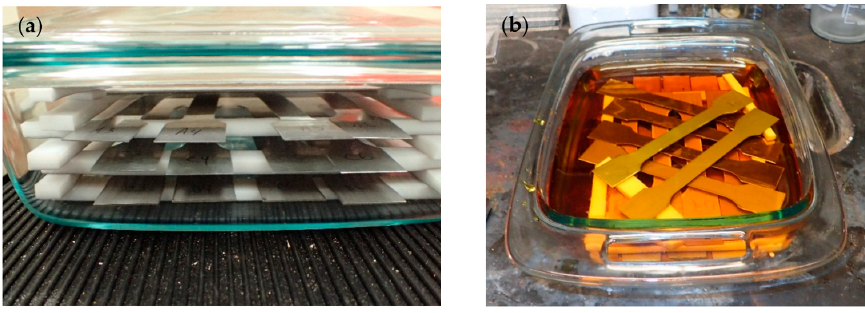
Figure 4. ( a ) Stacking sequence of the specimens; and ( b ) Submersion of the stacked specimens.